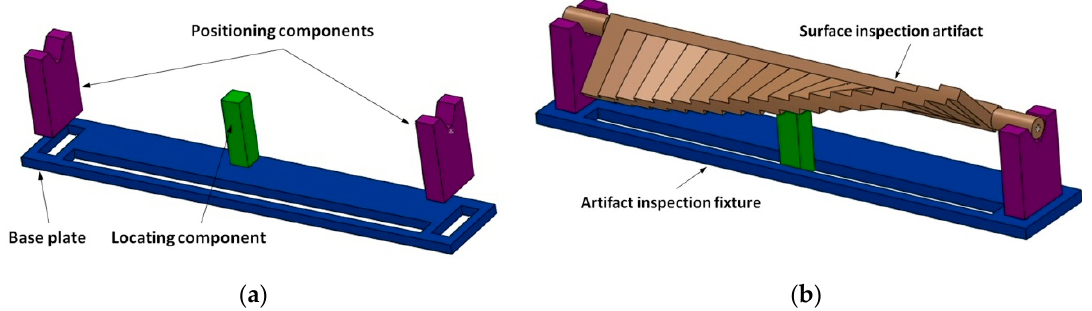
Figure 8. ( a ) The components of the artifact inspection fixture; ( b ) positioning of the artifact on the fixture.